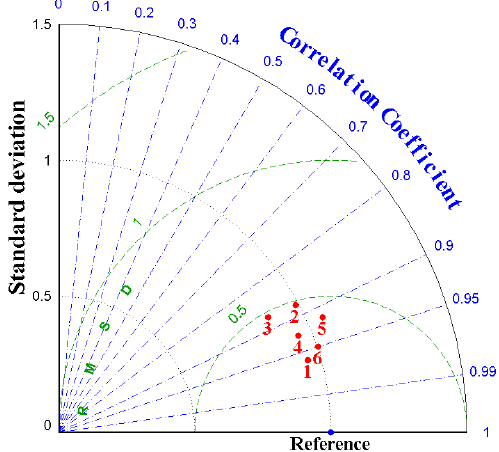
Figure 2. Taylor diagram representing model-data comparisons for surface elevation (1 = JMS043.78, 2 = JMS073.37, 3 = APP001.83, 4 = JMS018.23, 5 = JMS002.55, 6 = Sewells Point, reference RMSD value = 0.3 m).